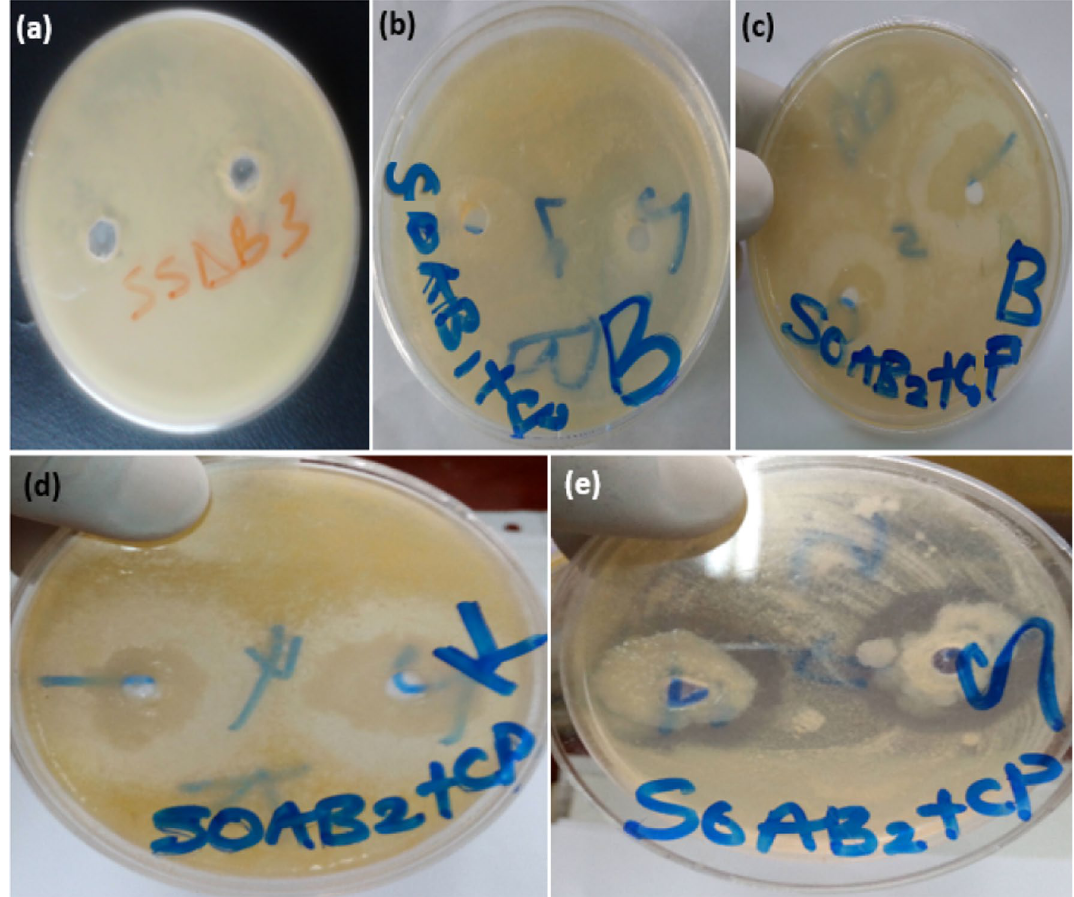
Fig. 5 Photographs showing the Zones of Inhibition (ZI) of a non-drug loaded Sesamum indicum oil based nanoemulsion (SOAB); b , c , d and e Ciprofloxacin-loaded Sesamum indicum oil based nanoemulsion (SOAB